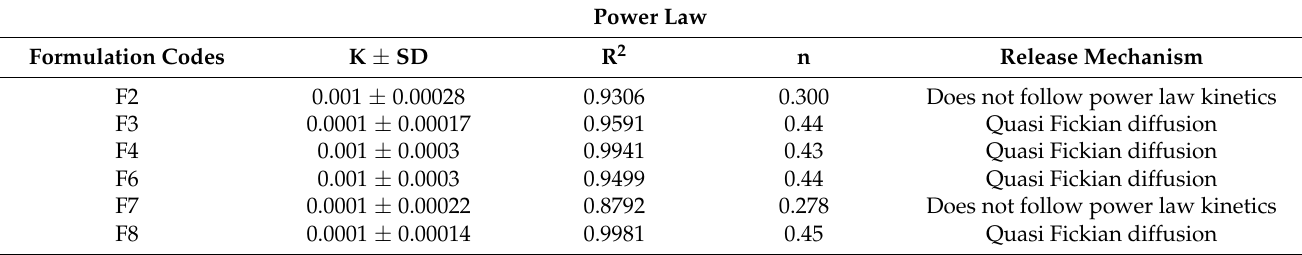
Table 11. Release kinetics of metronidazole floating effervescent tablets in 0.9%